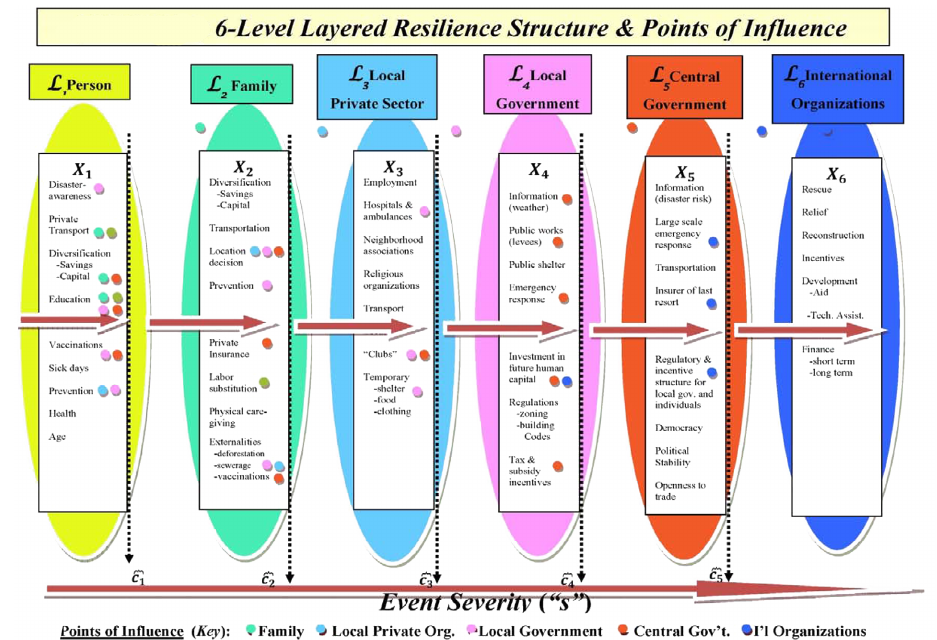
Figure 2. This figure illustrates the layered nature of resilience in human systems. Each layer is color-coded. The native resources ( X i ) that contribute to a given layer’s resilience are listed below it. Colored dots represent influence points, places where higher layers of that color can influence the targeted layer by augmenting or complementing its native resources and thus contribute to its resilience. For instance the international community can influence the resilience of a central government by helping with emergency response and by acting as an insurer of last resort. In contrast the international community is likely to be much less effective in promoting democracy, even though democracy has been shown to contribute significantly to national disaster